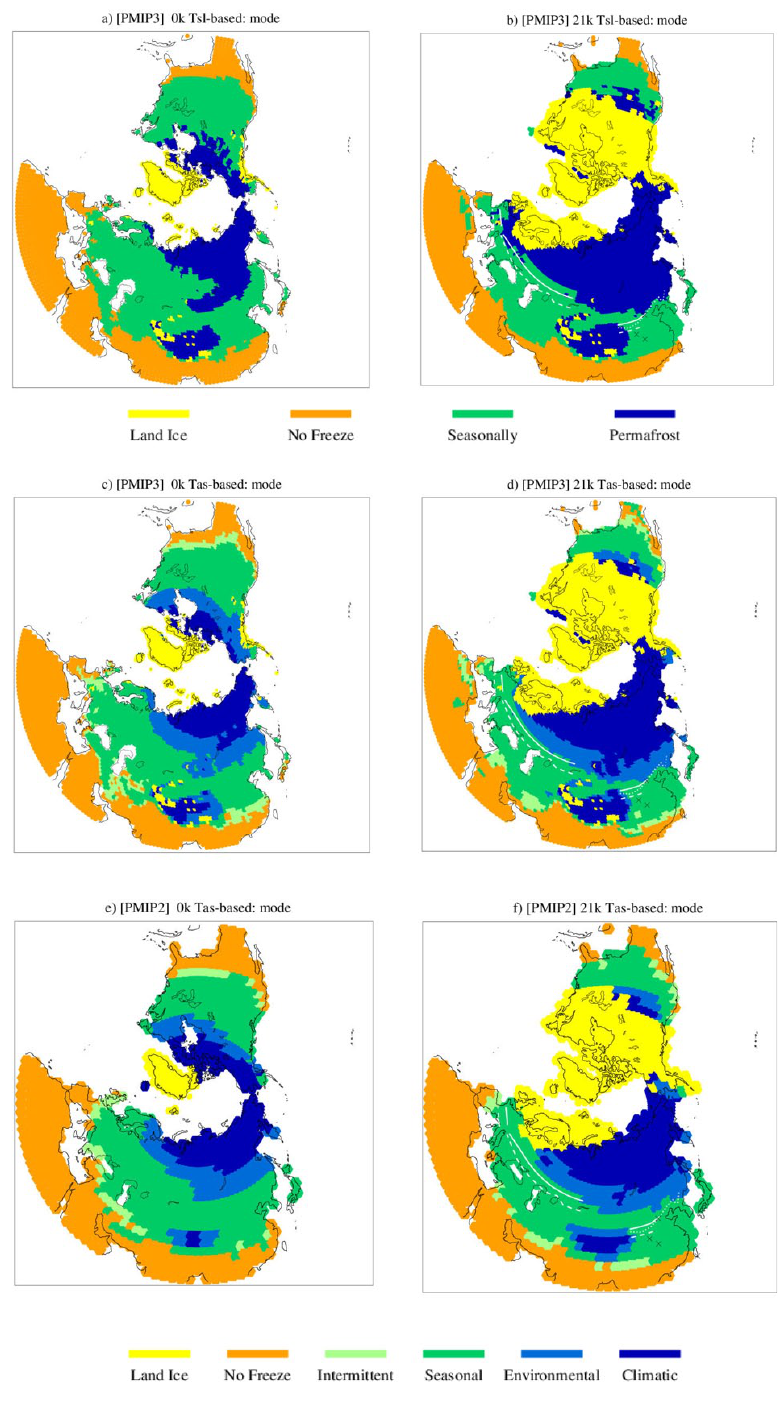
Fig. 2. Frozen ground distribution diagnosed from the Tsl for (a) the pre-industrial and (b) the LGM periods, from PMIP3 results. Multi- model mode (the most frequent categories in each grid box) was used. Colors denote permafrost zone (Pf; dark blue), transitional zone (Tr; blue), seasonally freezing zone (Sf; dark green), intermittently freezing zone (If; pale green), no-freezing zone (Nf; orange), and ice sheets (LI; yellow). White solid (dashed) lines denote the southern boundary of continuous (discontinuous) permafrost reconstructed by Vandenberghe et al. (2004, 2012), while dotted line denotes the reconstruction by Xu et al. (1988). Cross symbols (x) denote the presence of alpine permafrost by Xu et al. (1988). (c) and (d) same as (a) and (b) except that the diagnoses are T as -based. (e) and (f) same as (c) and (d) except for the PMIP2 results. (g) represents observation-based frozen ground distribution at the present day. Permafrost distribution was taken from the IPA map (Brown et al., 1998), and the seasonally freezing ground is determined by mean monthly air temperature at the surface (Saito et al.,